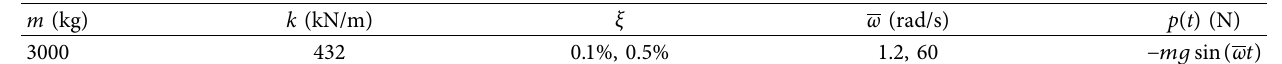
Table 5: Specification of a damped SDF